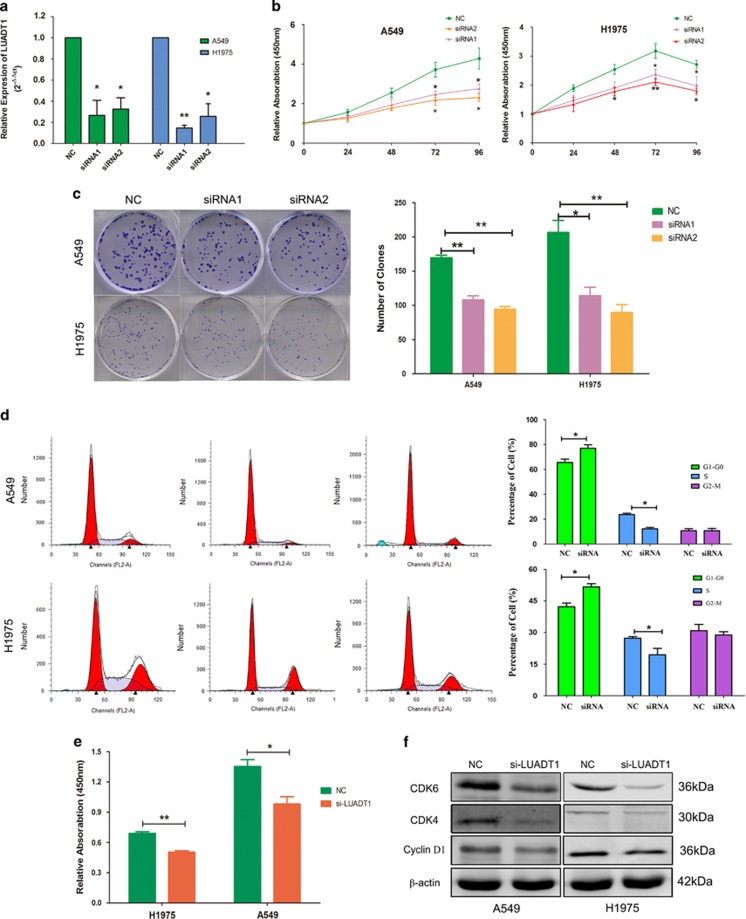
The silencing of LUADT1 inhibited LUAD cell proliferation in vitro. (a) Targeted siRNAs efficiently silenced LUADT1 in the A549 and H1975 cell lines. LUADT1 knockdown inhibited cell proliferation (CCK-8 assay, b) and clone formation (c) ability and induced cell cycle arrest at the G0–G1 stage (d) in A549 and H1975 cells. BrdU assay showed that siRNA-LUADT1 treatment significantly decreased relative absorbance at 450 nm (e). Western blot showed that cyclin D1, CDK4 and CDK6 were decreased after LUADT1 silence in A549 and H1975 cells (f). *P<0.05, **P<0.01. Error bars indicate means±S.E.M.